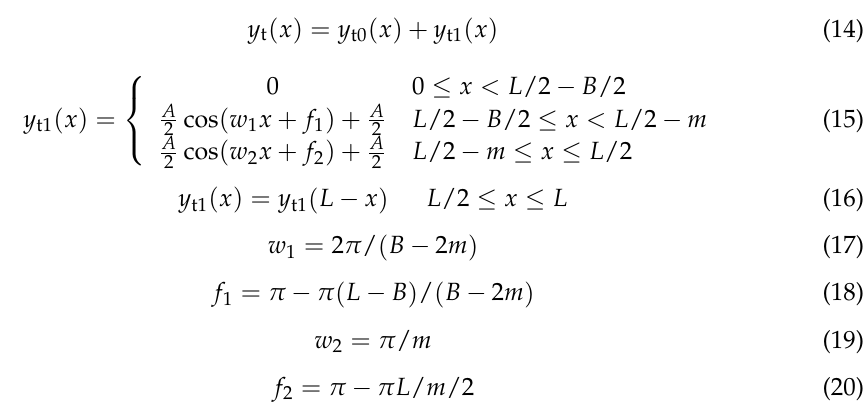
Figure 8. Curve of MVCplus after superposition. 4. Analysis of Adjusting Characteristics of MVCplus It can be seen from Figure 9 that compared with the quadratic gap crown control capability of CVC, the adjustment of MVCplus to the quadratic crown is almost linear, especially in the range of ± 100 mm, where roll shifting occurs more frequently, it is almost consistent with CVC (roll shifting distribution generally meets the normal distribution).